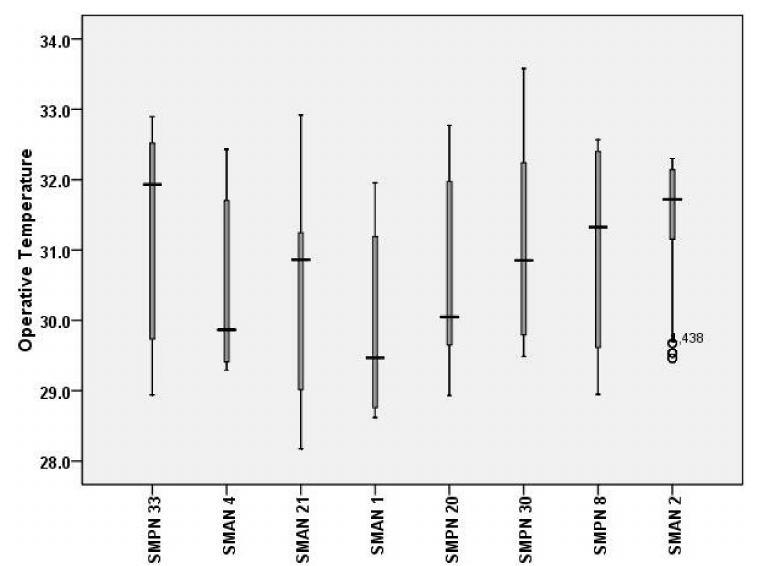
Figure 3. The box plot of operative temperature on each